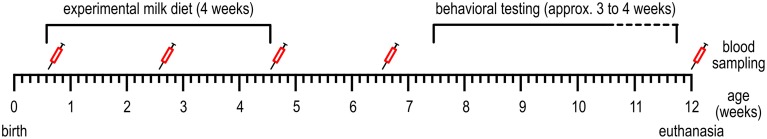
Timeline of the events conducted during the experiment. See Table 1 for more detailed information.